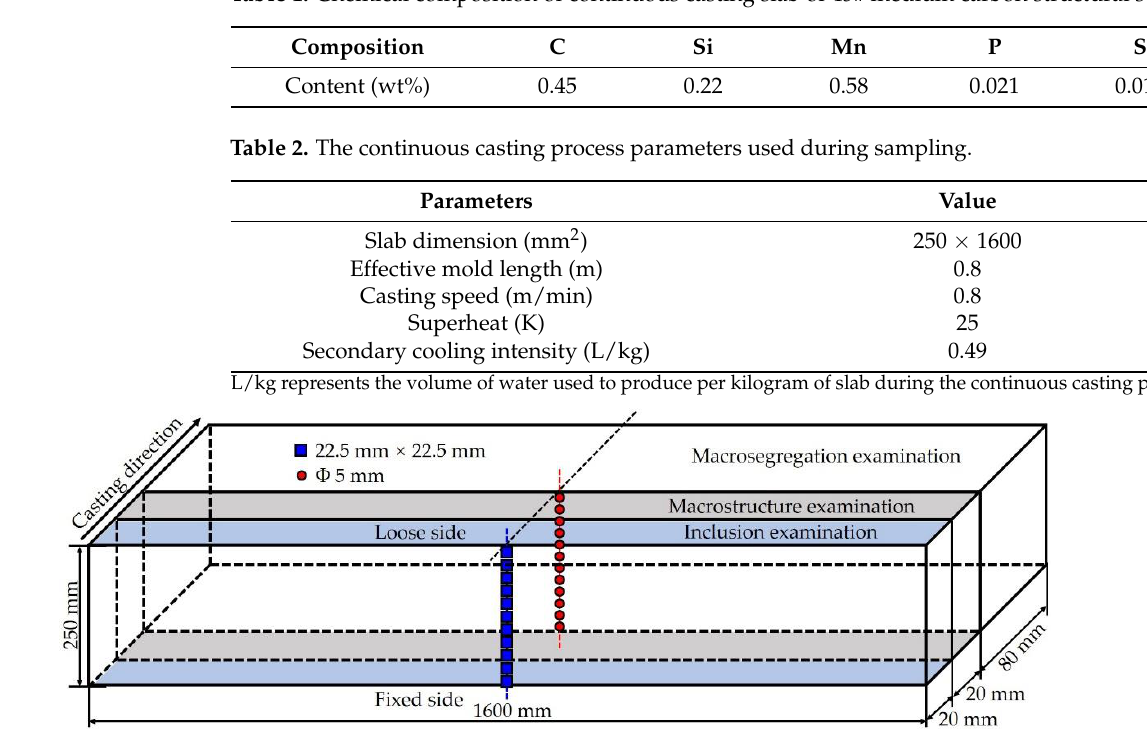
Figure 1. Sampling schemes for various examinations. Table 2. The continuous casting process parameters used during sampling.